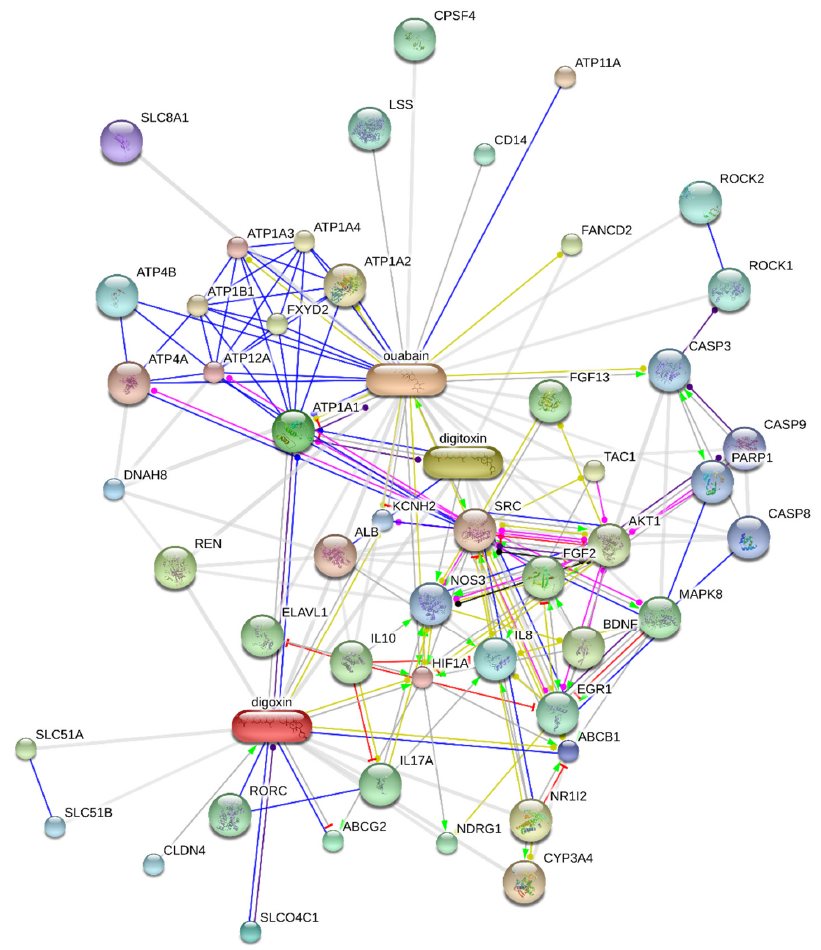
Figure 7. Predicted functional association network for cardiac steroids digoxin, digitoxin,